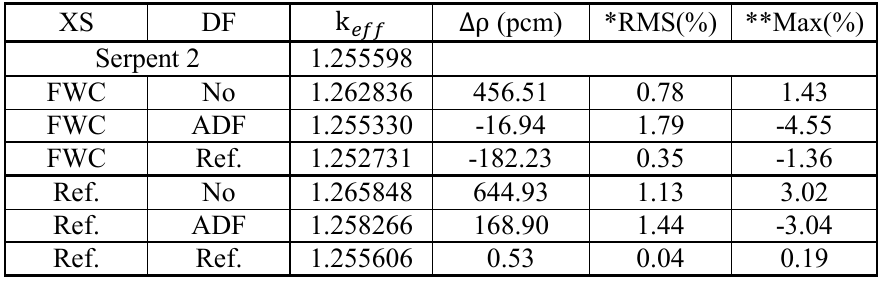
Table I. Results of nodal equivalence theory for the sPGSFR